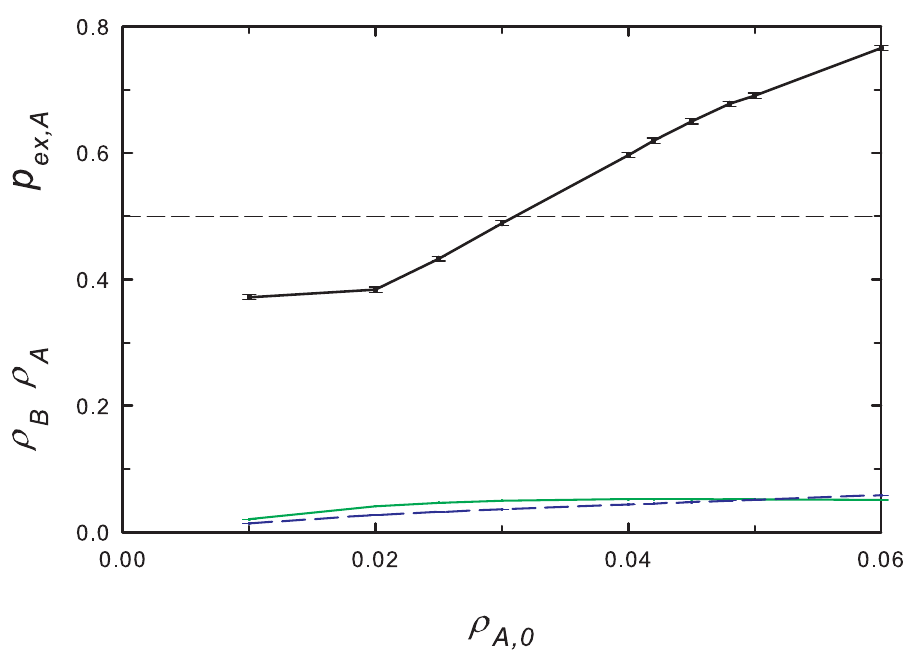
Fig 8. (Color online) Mean-field analysis for periodic environment with independent additive noise terms affecting each species. Slow-species extinction probability p ex , A (upper curve) and mean population densities(lower curves) (cid:22) r (solid) and (cid:22) r (dashed), versus initial density, with ρ B ,0 = ρ A ,0 . Noise intensity A B γ = 0.1, other parameters as in Fig 5.